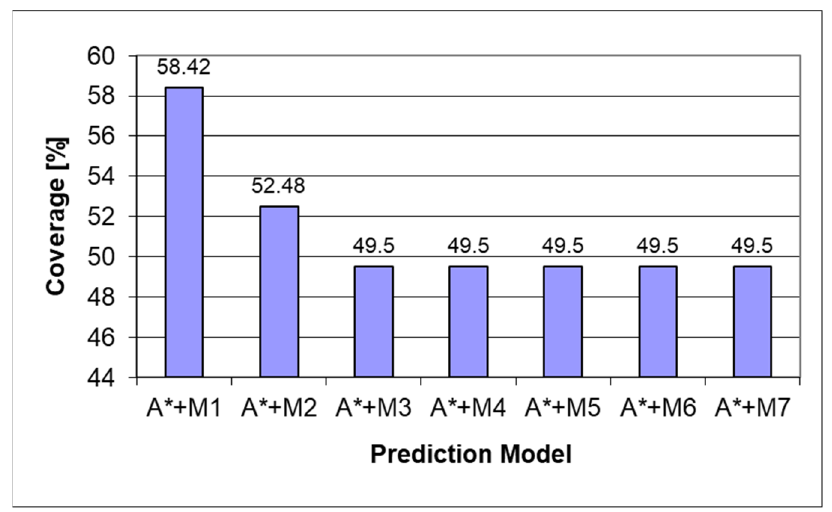
Figure 10. Predictor coverage graph for the perfect heuristic on the “Students” dataset. Table 3. Comparison between different predictors on the mixed dataset.